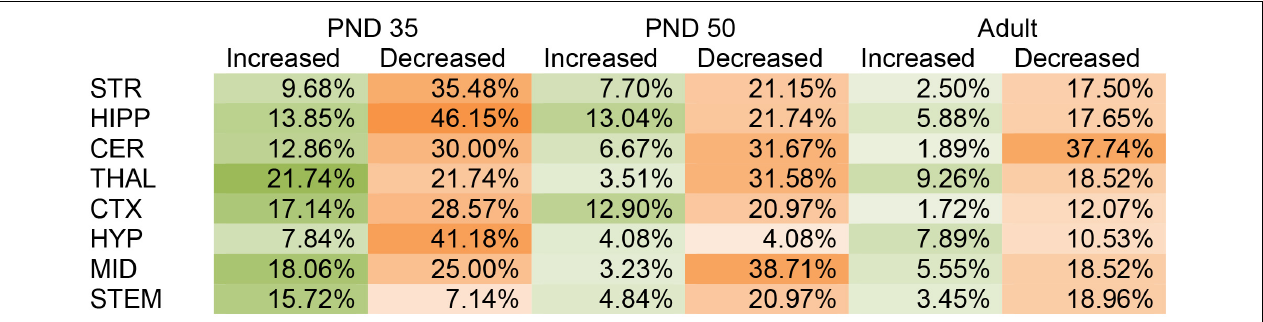
FIGURE 1 | Percentage of significant changes in the CD1 female mouse brain lipidome in post-natal day (PND) 35, PND 50, and adult mice after 2-h exposure to systemic CP 55,940 (CP). The green portions of the figure represent the percentage of lipids detected in each brain area (row) that increased with acute 3 mg/kg CP relative to vehicle in each age group (column) and the orange parts represent the percentage of lipids detected in each brain area (row) that decreased with acute 3 mg/kg CP relative to vehicle in each age group (column). The areas with the most changes are shaded in darker colors. STR, striatum; HIPP, hippocampus; CER, cerebellum; THAL, thalamus; CTX, cortex; HYP, hypothalamus; MID, midbrain; STEM, brainstem. For example, in the adult MID, there were 54 lipids detected and 13 of them changed with acute CP. Of the 13 changes, 3 of them were increases. 3 was then divided by the number of lipids detected, which in this case was 54, and multiplied by 100 to yield the percentage increased (5.55%). For the adult MID, 10 lipids decreased with acute CP out of 54 detected, giving a percentage of 18.52% for the proportion of the lipidome that decreased.